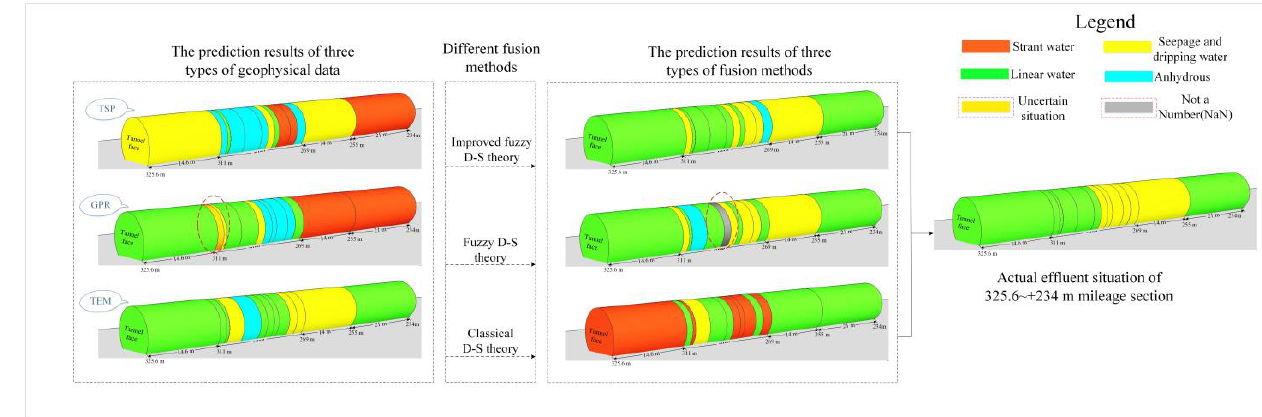
Figure 11. Prediction results of the effluent conditions for mileage 325~+ 234 m.